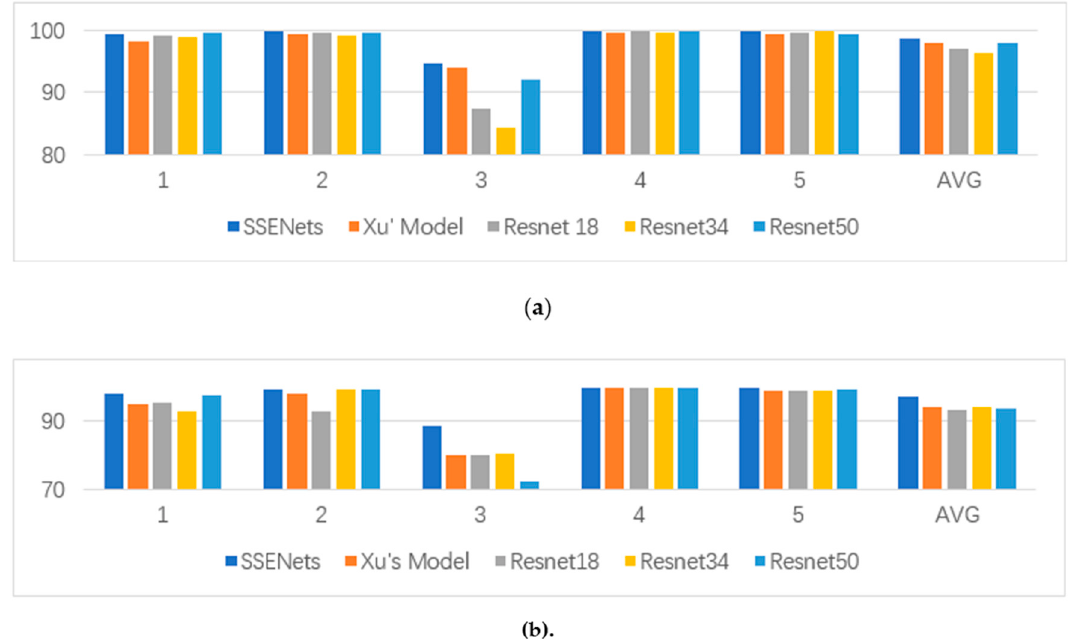
Figure 6. Histograms of 5-fold cross-validation. ( a ) The detection accuracy of training; ( b ) The detection accuracy of testing.